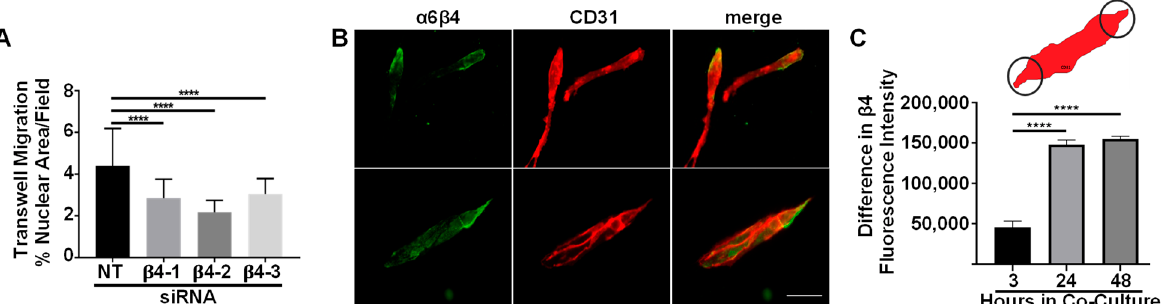
Figure 3. Depletion of α 6 β 4 reduces endothelial cell migration: ( A ) Analysis of nuclear staining in transwell migration assays with non-targeting (NT) or β 4-targeting cells. Fifteen fields were analyzed from each of two independent experiments. Plotted is the mean percentage of area per field stained for nuclei ± s.d. n = 30. Data were analyzed by one-way ANOVA and Dunnett’s multiple comparisons test; ( B , C ) the polarized expression of β 4 in endothelial cells was analyzed at 3, 24, and 48 h; ( B ) representative images of endothelial cells at 24 h immunostained for the β 4 integrin subunit (green) and CD31 (red). Scale bar = 100 µm; ( C ) plotted is the mean difference in β 4/CD31 fluorescence intensity between polar ends of endothelial cells or cell cords using a constant ROI (See top panel in C for diagram) ± s.e.m. Fifteen fields were analyzed from three independent experiments (n = 3 independent experiments). Data were analyzed by one-way ANOVA and the Tukey’s multiple comparisons test. *** p ≤ 0.001, **** p ≤ 0.0001.